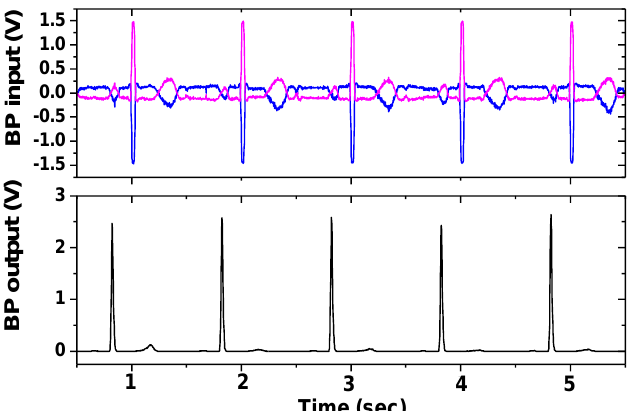
Figure 26. Measured result of band power channels. Positive and negative inputs are indicated with blue and red lines, and output is indicated with black lines.